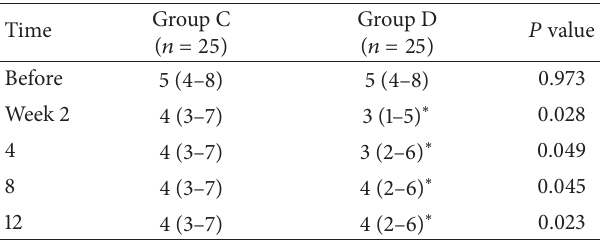
Table 2: Visual analogue scale of back